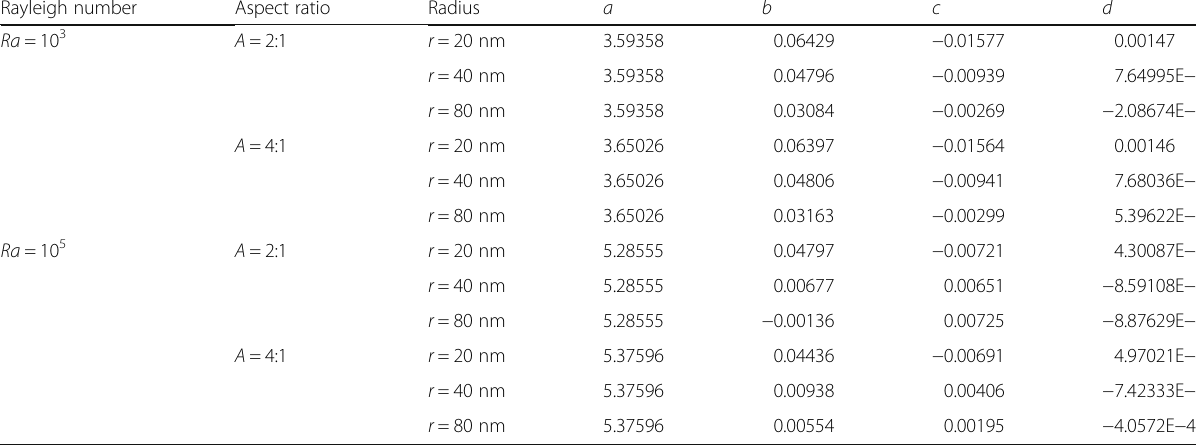
Table 5 The constant parameters in Eq. (11). The constant parameters in Eq. (11) at different Rayleigh numbers, aspect ratios, and radiuses Rayleigh